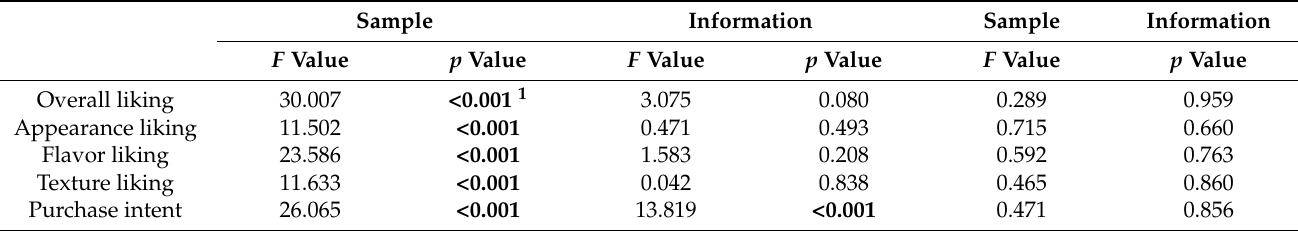
Table 6. F values and p values associated with the effects of sample, information and a two-way interaction between two factors on consumer acceptability in relation to eight cookie